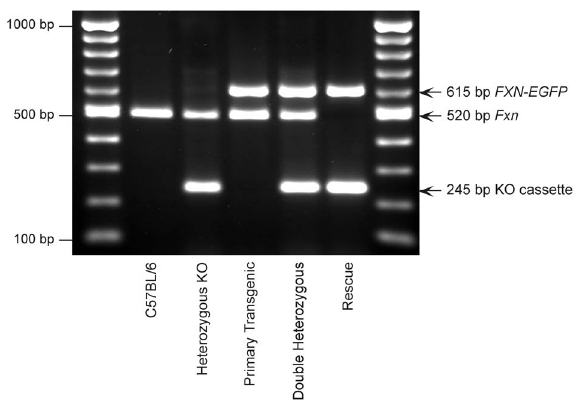
Figure 2. PCR-based genotype analysis. The generation of transgenic mice containing the FXN-EGFP genomic reporter construct in a murine Fxn knockout background was analyzed by PCR. The 615 bp band corresponds to the EGFP sequence in the FXN-EGFP transgene; the 520 bp band corresponds to the endogenous wild type murine Fxn gene; the 245 bp band corresponds to the Fxn knockout allele. C57BL/ 6, wild-type mouse ( Fxn + / + ); Heterozygous KO, ( Fxn + / 2 ); Primary transgenic, ( FXN-EGFP + , Fxn + / + ); Double heterozygous, ( FXN-EGFP + , Fxn + / 2 ); Rescue, ( FXN-EGFP + , Fxn 2 / 2